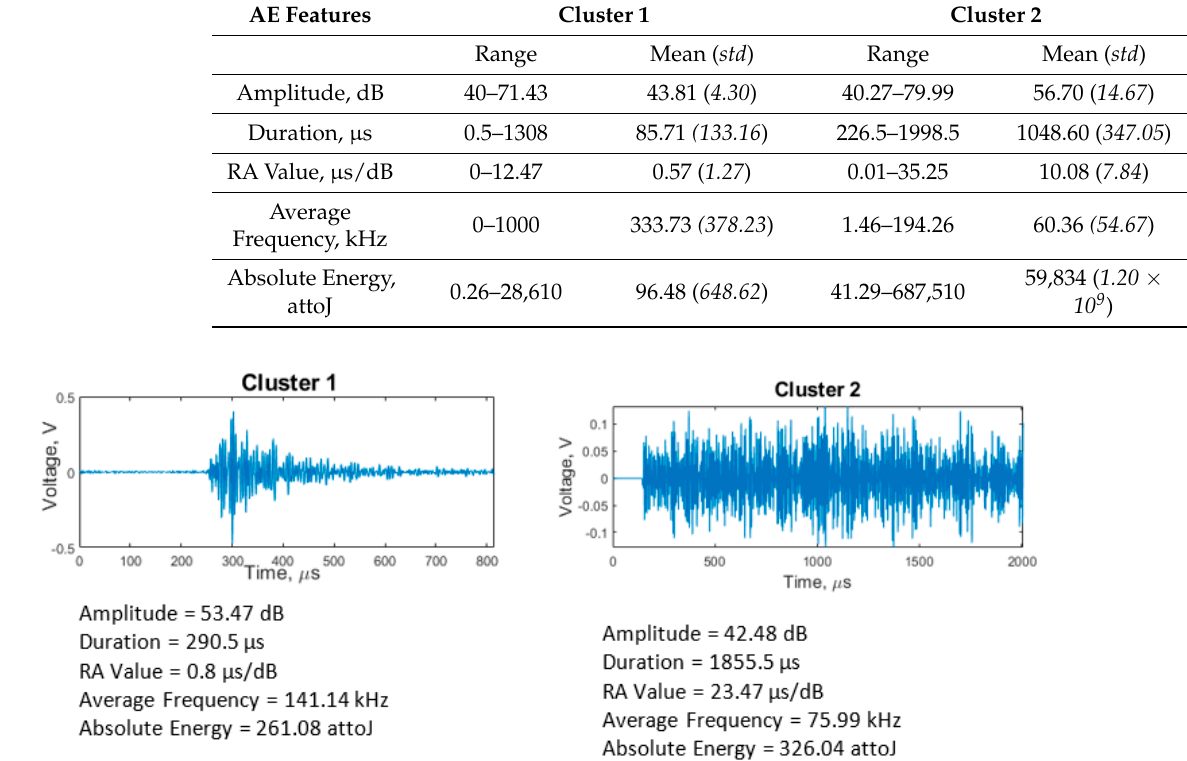
Figure 8. Waveforms of hits in adhesive wear clusters and their features. Cluster 1 event is a burst emission while cluster 2 event is a continuous emission.